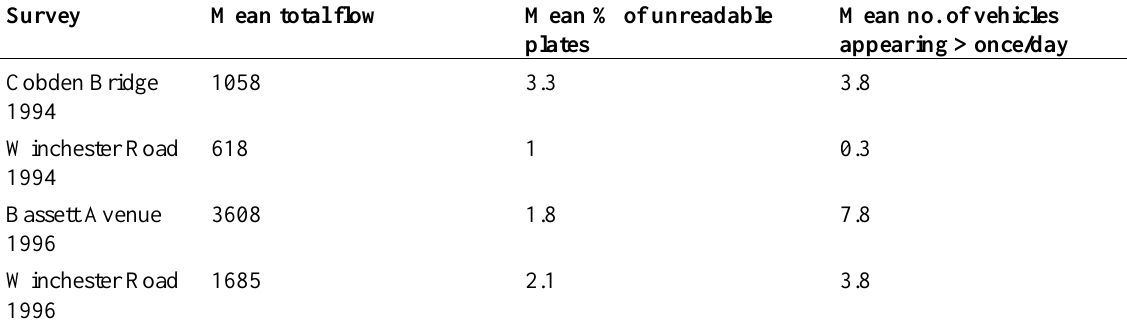
Table 2. The mean flows, percent of unreadable registrations and the mean number of vehicles appearing more than once during the observation periods in the 1994 and 1996 registration plate